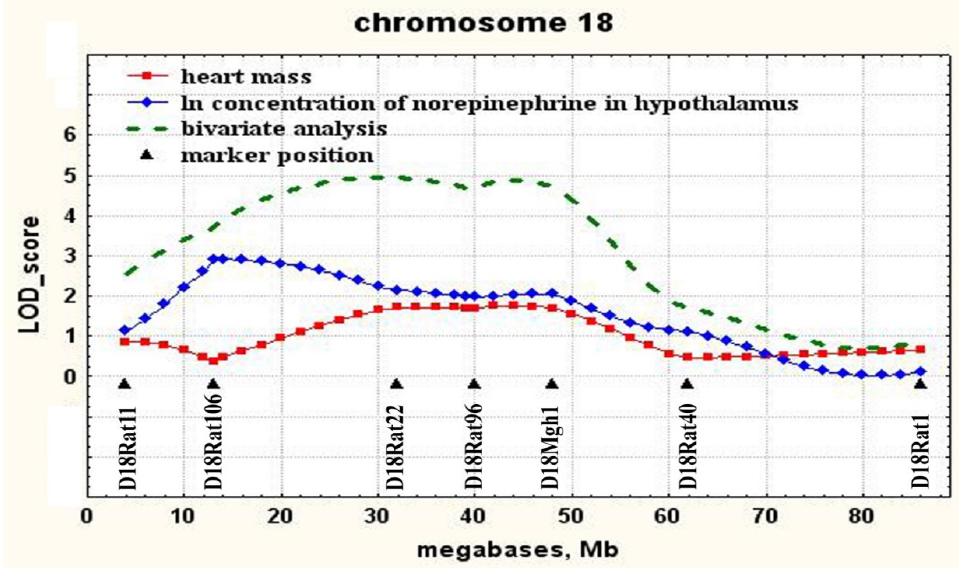
Figure 2. The covariance of two traits (the concentration of norepinephrine in the hypothalamus and heart mass) at the locus on chromosome 18. Table 4. QTL on chromosome 18 associated with heart mass in male rats F 2 (ISIAHxWAG) aged 6